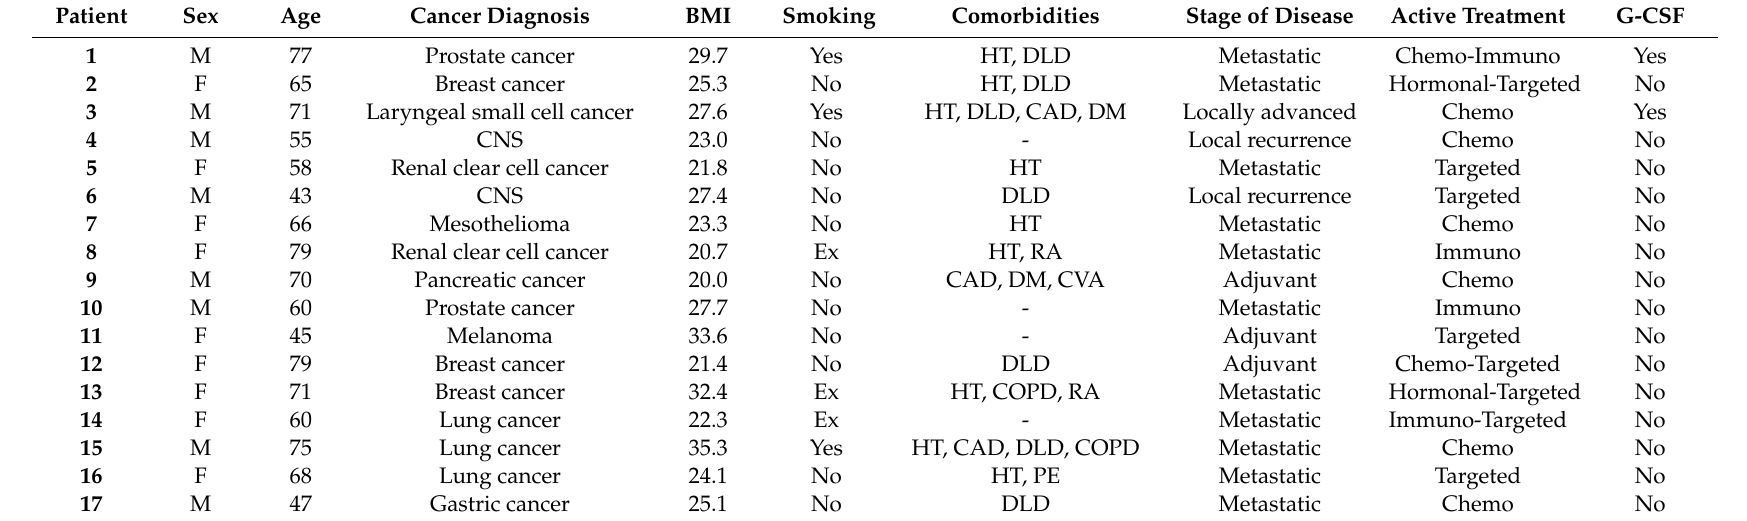
Table 2. Clinical characteristics of SARS-CoV-2-positive cancer patients on active